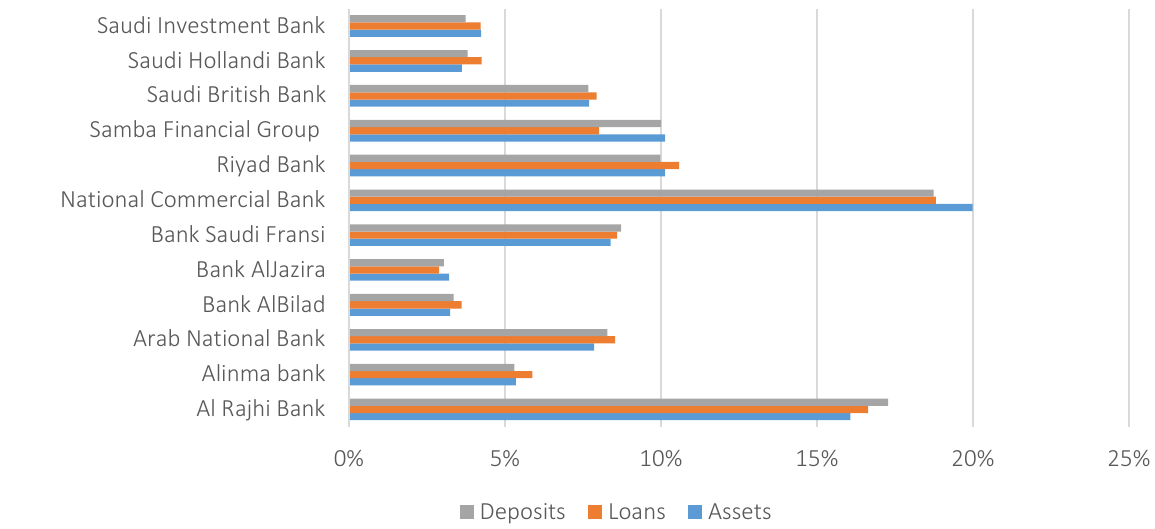
Figure 1. Saudi banks’ market share (%) concerning deposits, loans, and assets in 2018